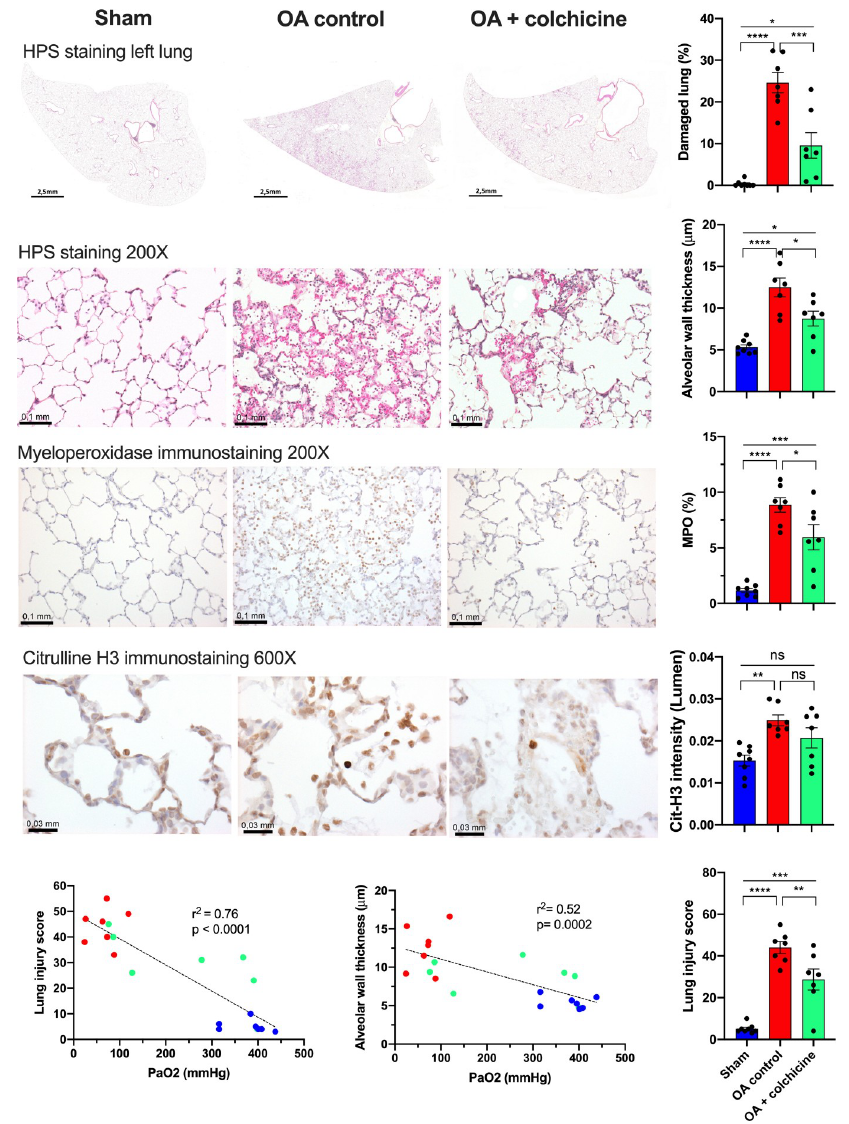
Fig 2. Effects of colchicine therapy on lung injury, neutrophils recruitment, and NETosis after oleic acid-induced ALI. Values are mean ± SEM. ���� p < 0.0001; ��� p < 0.001, �� p < 0.01; � p < 0.05. unstimulated blood from oleic acid treated animals, we observed an increase in His48 fluores- cence of neutrophils that was normalized by colchicine treatment. Additionally, cell surface CD4 and CD8 on respective lymphocyte sub-populations were increased after oleic acid stimu- lation, and also normalized by colchicine therapy.